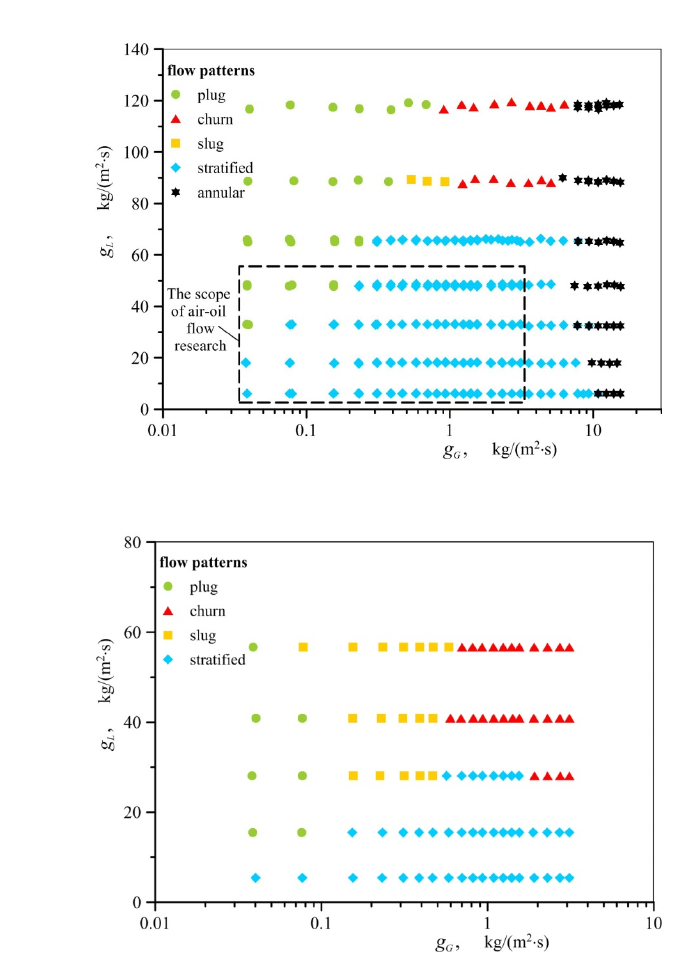
Figure 4. Conditions corresponding to occurrence of gas − liquid flow patterns: ( a ) air − water flow, ( b ) air − oil flow. Materials 2020 , 13 , x FOR PEER REVIEW